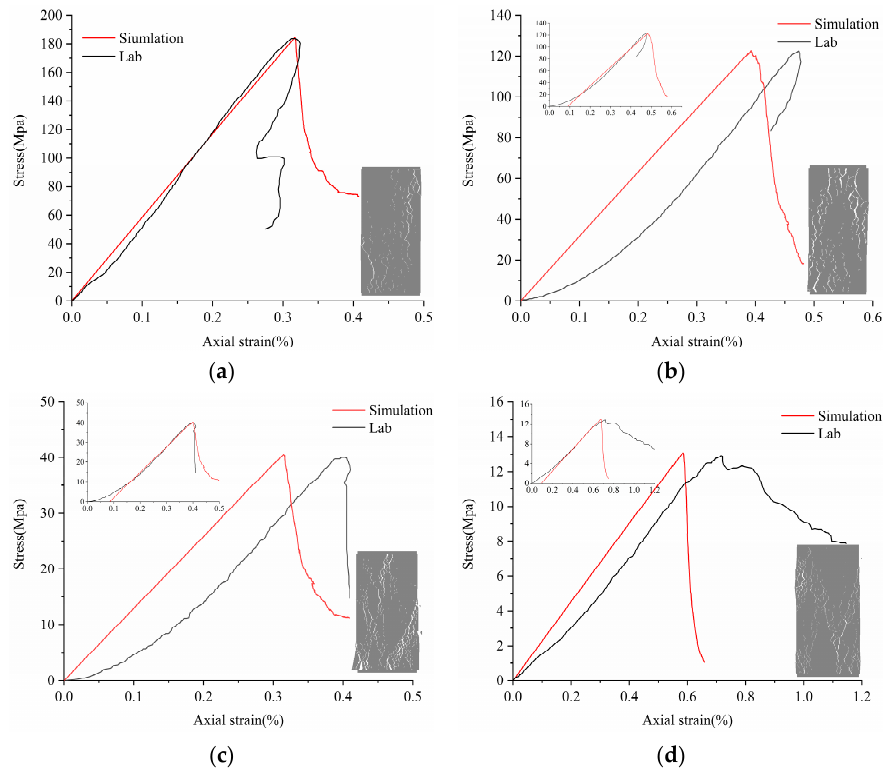
Figure 4. Calibration of Voronoi models to ( a ) LdB granite, ( b ) Augig granite, ( c ) TS, and ( d ) coal.